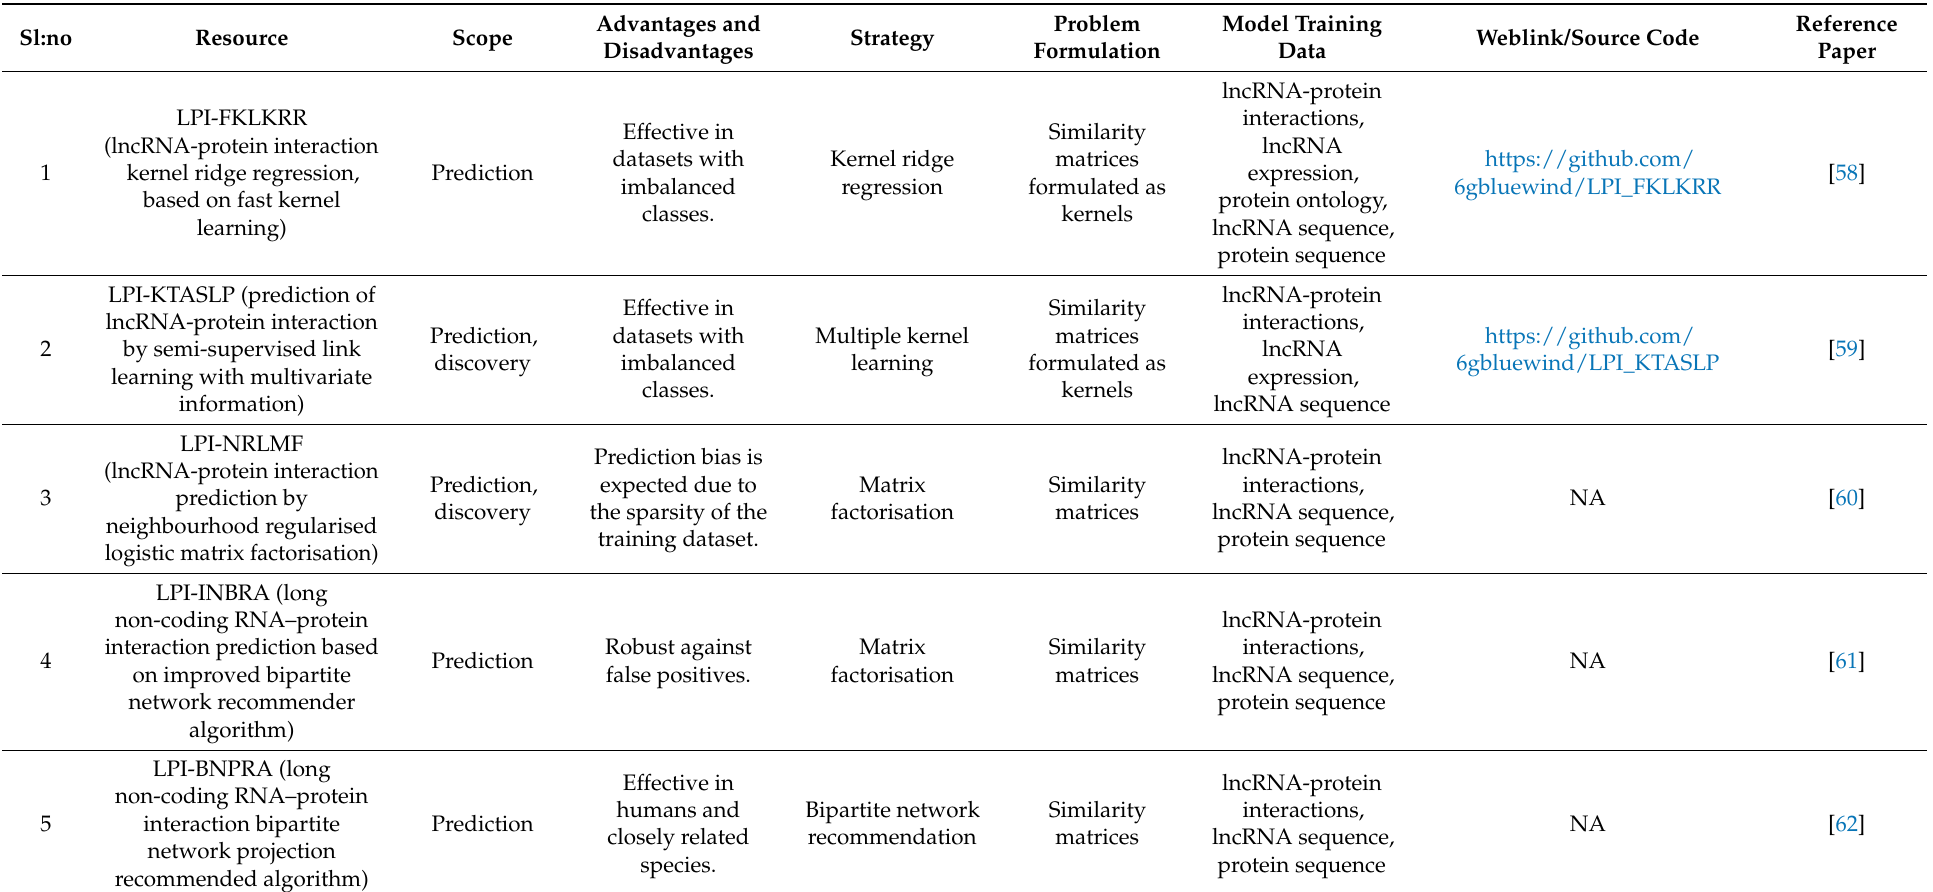
Table 2. A comparison of machine learning algorithms used to predict lncRNA-protein interactions. Important attributes of these machine learning algorithms, including their scope, strategies, training data, effectiveness and reproducibility are listed. More than half of these methods are not reproducible as their source code is proprietary or not available. A